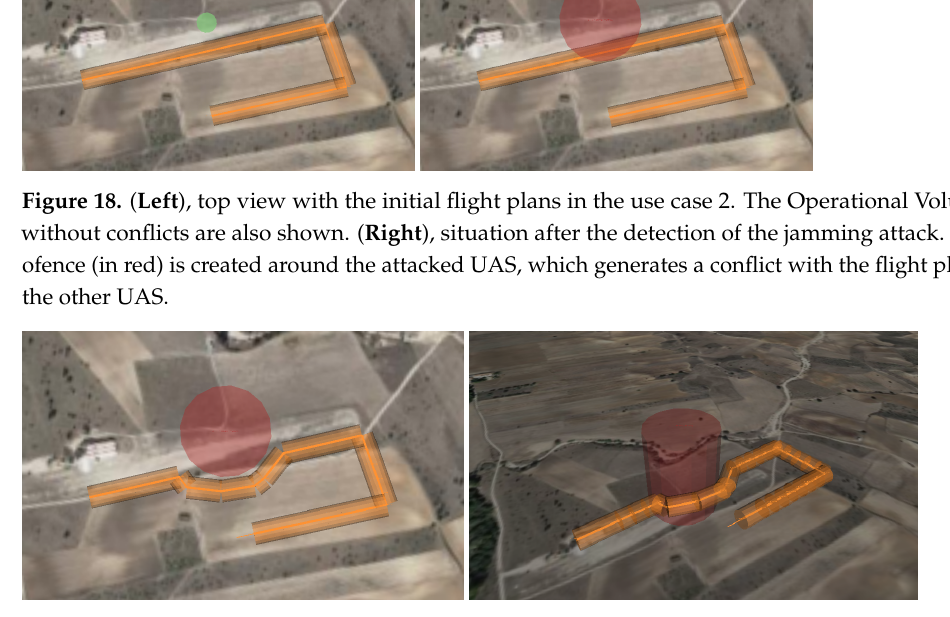
Figure 19. A top ( left ) and a perspective ( right ) view of the optimal solution in the use case 2. An alternative flight plan for UAS 2 is generated to avoid the